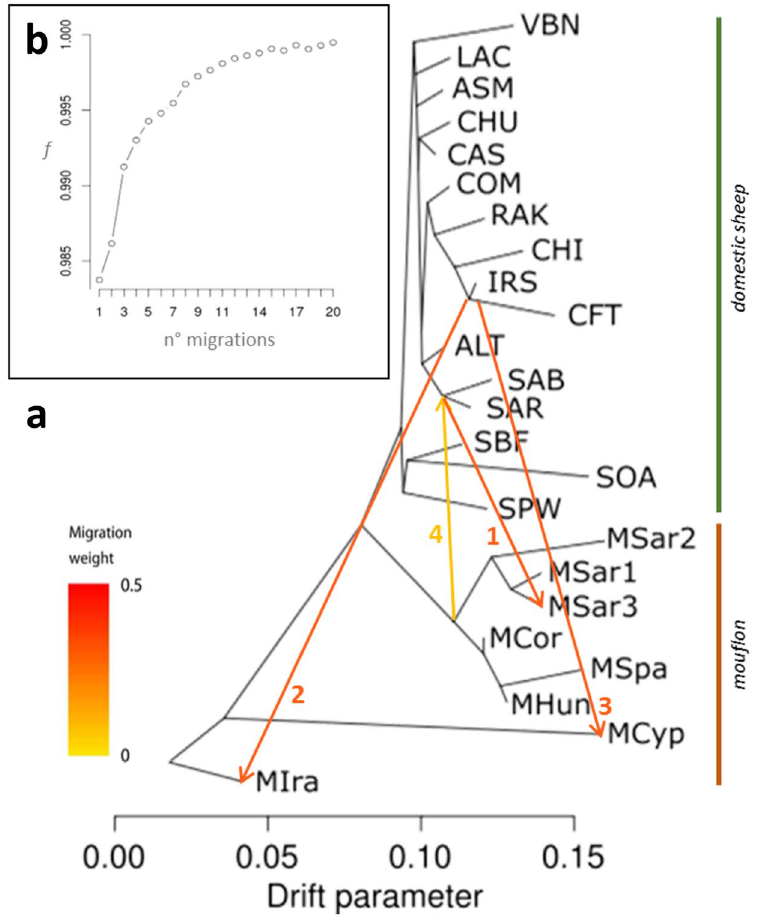
Figure 3. Treemix plot. ( a ) Phylogenetic network inferred by Treemix of the relationships between mouflon and domestic sheep populations. The first four migration edges between populations are shown with arrows pointing in the direction toward the recipient group, and coloured according to the ancestry percentage received from the donor. The numbers associated with each vector identify the identification order. ( b ) The inset shows the f index representing the fraction of the variance in the sample covariance matrix (  W ) accounted for by the model covariance matrix ( W ), as a function of the number of modelled migration events. For population abbreviations see Table